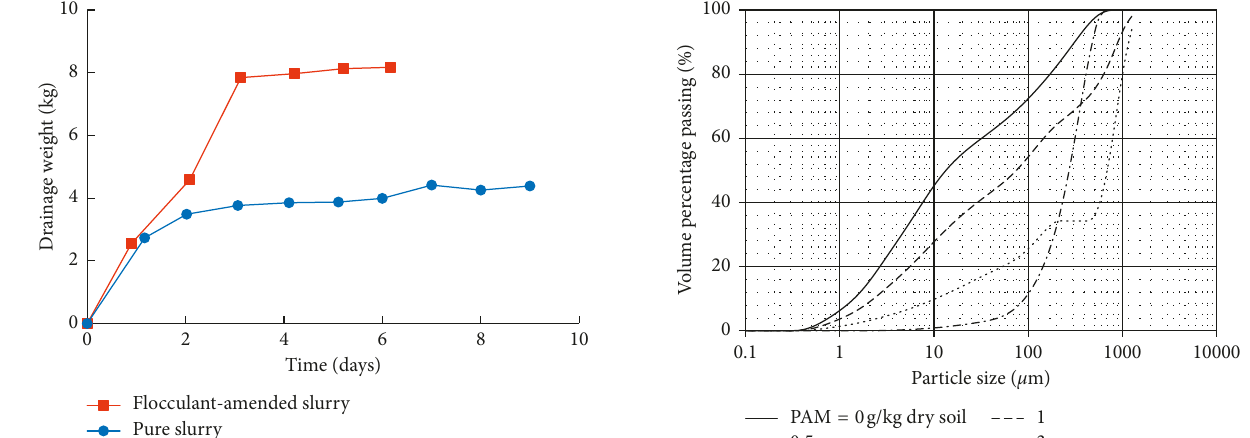
Dewatering treatment without flocculant